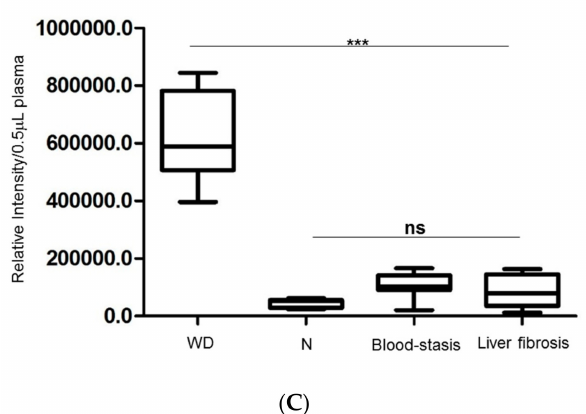
Figure 3. ( A ) Compares the expression of fibrinogen in plasma between normal (N) and WD patient by immunoblots. 2-DE western blot shows the di ff erent type of fibrinogen ( α , β and γ ) with a specific reactive antihuman antibody. ( B ) Immunohistochemical analysis of fibrinogen in the normal part of liver (N) and WD cirrhotic liver are observed under microscope. The hepatocytes were showing obvious staining of fibrinogen in WD patients as black arrows indicate while great amount of inflammatory cells were observed in WD samples as demonstrated by red arrows. However, faint staining of fibrinogen in hepatocytes was found in normal liver sample. ( C ) Changes of fibrinogen level in plasma from clinical subjects with WD, blood-stasis, hepatic fibrosis and healthy donors. Each sample was analyzed in triplicate with specific antibody of fibrinogen in dot blot assay. These results were analyzed statistically by two-way ANOVA and fibrinogen significantly expressed in patients’ plasma with Wilson’s disease (*** p <